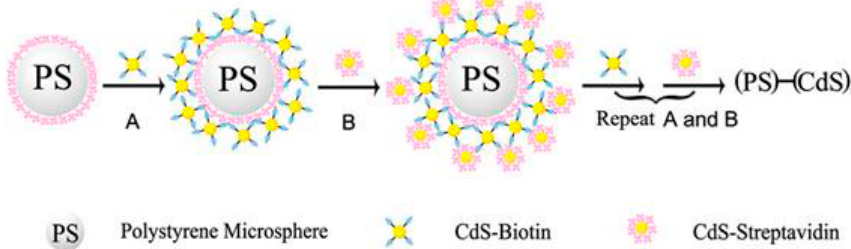
Figure 6. Schematic illustration of the formation of the PS–(CdS)n assemblies. Reproduced from [65], with permission from American Chemical Society, 2019.